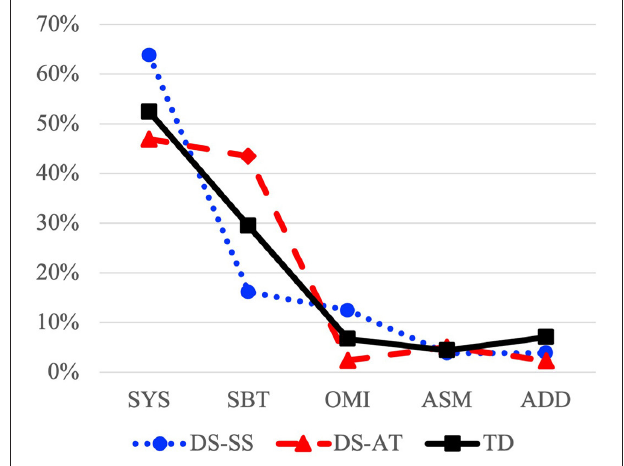
FIGURE 1 | Profiles of relative frequency of processes (in percentages) by classes (SYS, Syllable Structure; SBT, Substitution; OMI, Omission; ASM, Assimilation; ADD, Addition) for DS subgroups (DS-SS, Spontaneous Speech; DS-AT, Articulation Test) and TD group.